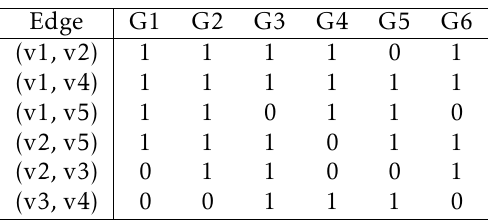
Table 3. DSMatrix for graph streams of Fig. 1